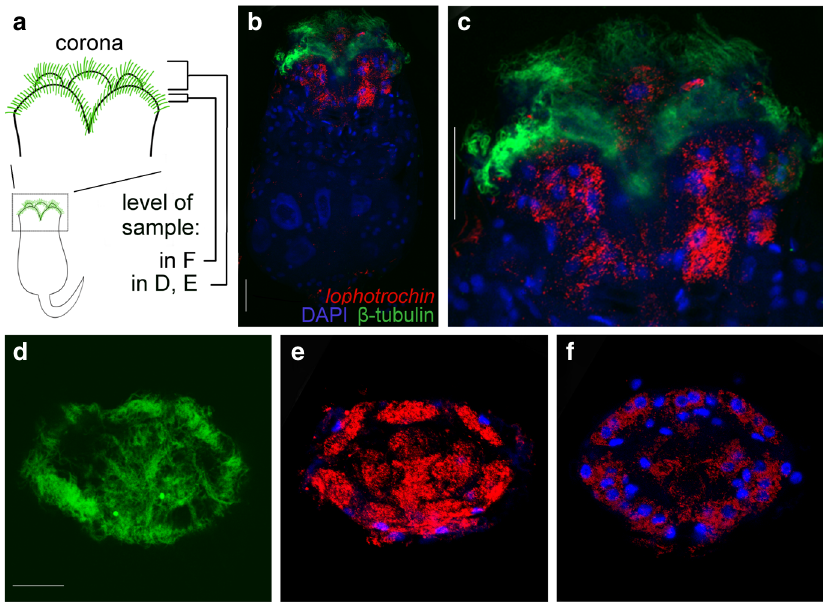
Fig. 6 Lophotrochin expression in rotifer Brachionus calyci fl orus . a Diagram of the Brachionus body plan and ciliary band (in green). Corona region enlarged. The positions of the confocal slabs of ( d – f ) are indicated, ventral view. b Confocal image, ventral view of animal, tail omitted. Lophotrochin is expressed in cells of the corona. Cilia in green, lophotrochin RNA in red, and DNA (DAPI) in blue. c Corona region enlarged from ( b ). d Anterior view of corona cilia. There are two concentric ciliary crowns in the corona: the outer crown (cingulum) and the inner crown (pseudotrochus). e Anterior view of lophotrochin RNA expression in ciliated cells. Expression can be seen in both outer and inner ciliary crowns. f Confocal section, posterior of ( e ). d – f are from the same individual. Scale bars: 50 μ m. For each in situ hybridization, at least 20 animals were stained and all had the pattern